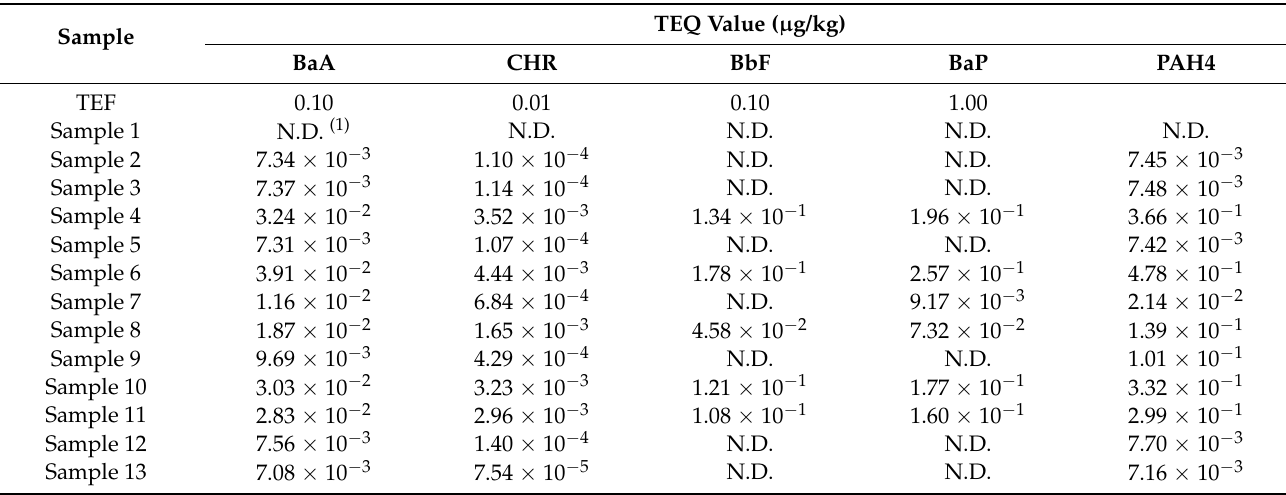
Table 5. TEQ values for PAH4 concentration in herbal medicines analyzed using typical pretreatment method.